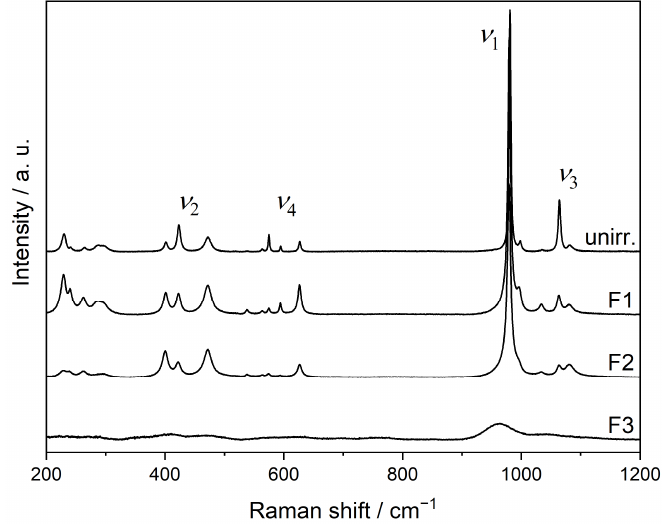
Figure 9. Raman spectra of SmPO 4 FIB lamellae after triple irradiation with multienergy Au ions at different fluences compared to unirradiated monazite-structured SmPO 4 (Fig. reproduced from [56]).